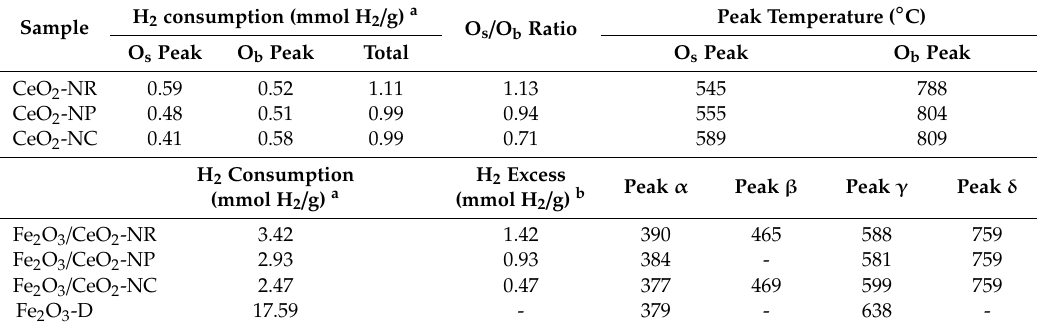
Figure 5. H 2 -TPR profiles of bare CeO 2 , Fe 2 O 3 -D, and Fe 2 O 3 / CeO 2 samples. Figure 5. H 2 ‐ TPR profiles of bare CeO 2 , Fe 2 O 3 ‐ D, and Fe 2 O 3 /CeO 2 samples. Table 2. Redox properties of bare CeO 2 , Fe 2 O 3 -D, and Fe 2 O 3 / CeO 2 Table 2. Redox properties of bare CeO 2 , Fe 2 O 3 ‐ D, and Fe 2 O 3 /CeO 2 samples.